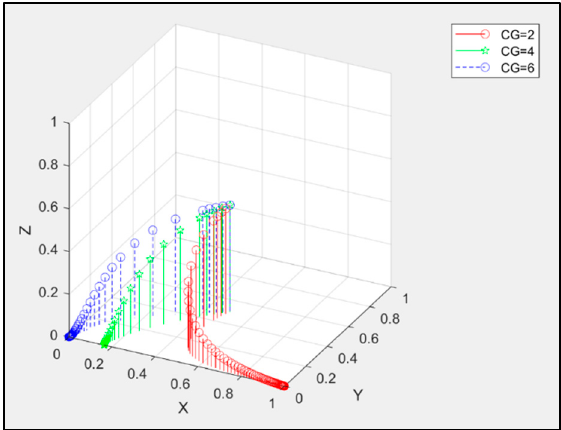
Figure 7. The influence of supervision cost (C G ) on the strategic choice of each party.